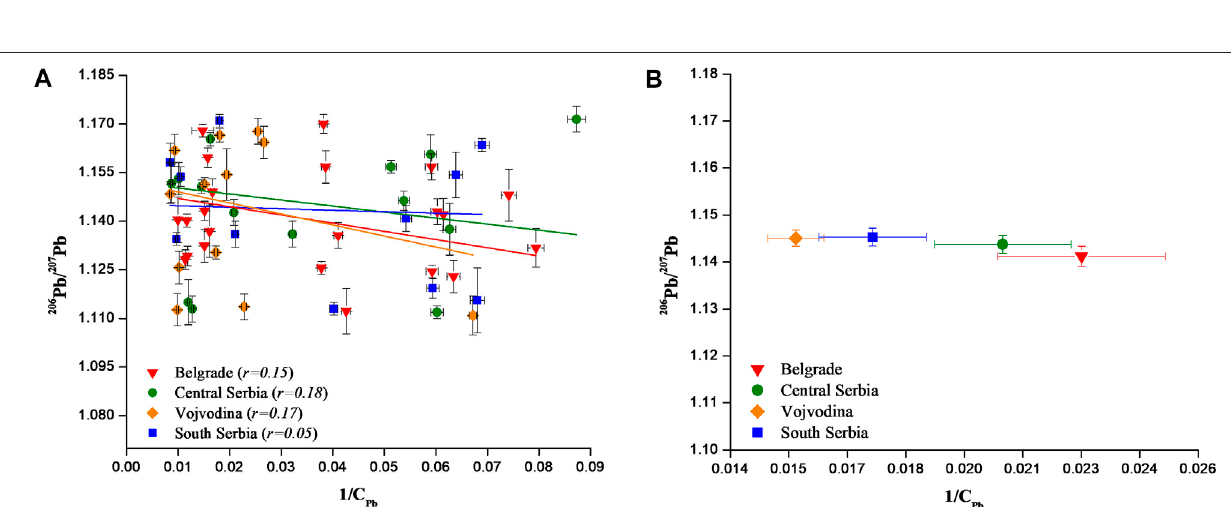
FIGURE 7 | (A) Possible isotopic signature of pollutant Pb sources in Serbian wines determined from 206 Pb/ 207 Pb ratio vs. 1/C Pb . (B) Plot of average 206 Pb/ 207 Pb ratio vs. average 1/C Pb for four Serbian regions. Error bars represent standard deviations between